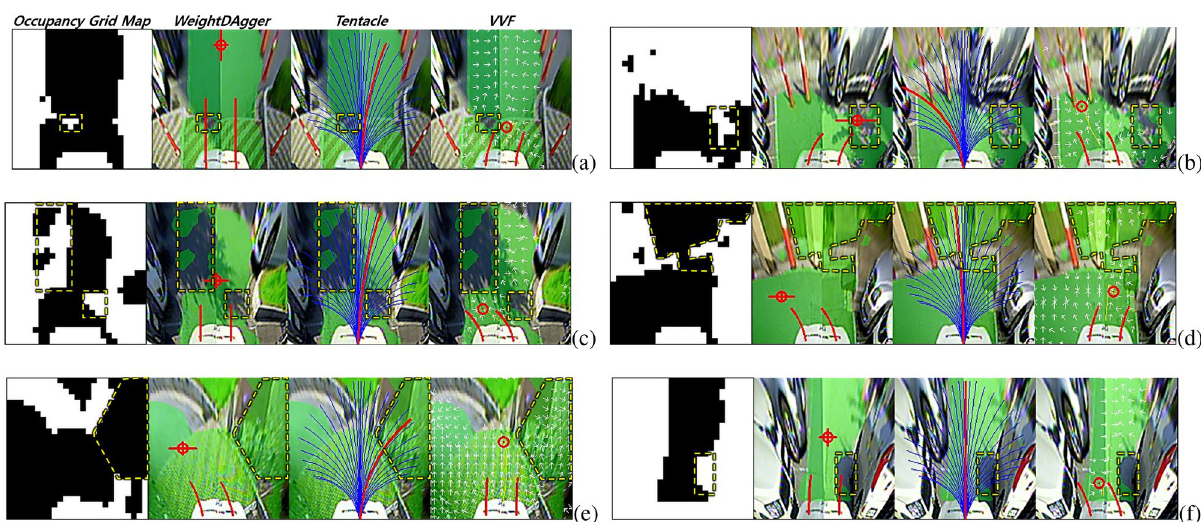
Figure 14. Driving results with WeightDAgger when the occupancy grid map contained noise. WeightDAgger did not encounter any problems in this situation. However, the vehicle could not drive smoothly or headed towards obstacles with Tentacle and VVF . ( a ) Noise from misrecognition; ( b, c , and g ) Noise by shadow; ( d, e ) Noise at the road